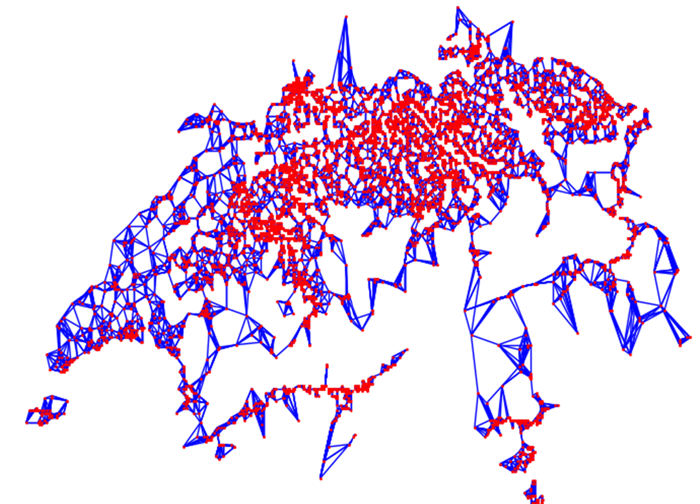
Figure 2. Example of a graph constructed using the locations (coordinates) of the monitored PV plants over Switzerland. The edges are selected using the 10 nearest neighboring